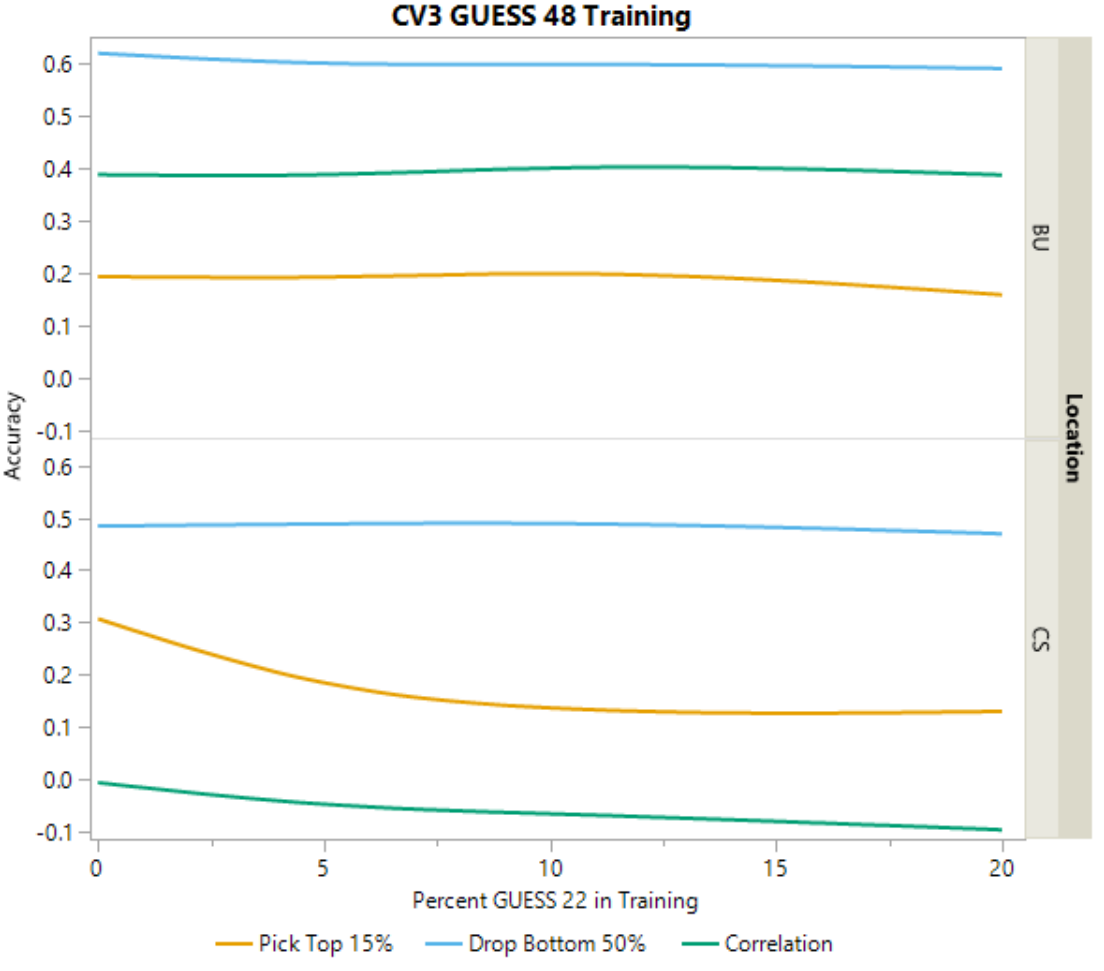
Figure 6. Prediction accuracies for CV3 in Bushland (BU) and College Station (CS). Accuracies for grain yield are presented with varying levels of GUESS 22 being added to the training data that include all of GUESS 48. Accuracy for grain yield was assessed in three ways, the proportion of hybrids correctly predicted in the top 15%, the proportion of hybrids correctly predicted in the bottom 50%, and correlation between predicted and actual values.